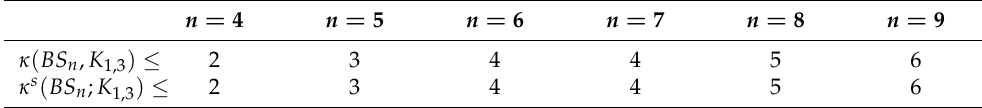
Table 1. The upper bounds of K 1,3 -(sub)structure connectivity.